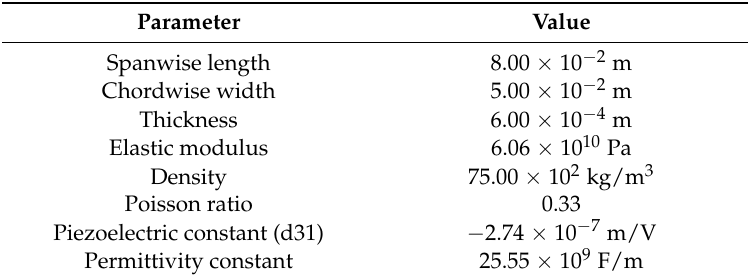
Table 2. Geometric and material parameters of the PZT-5H layers.